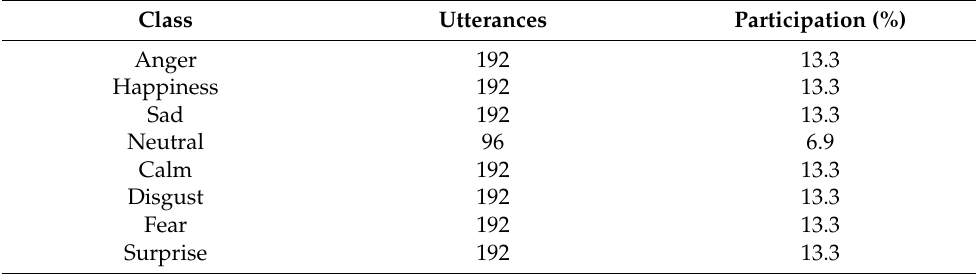
Table 2. Distribution of different emotions in the dataset